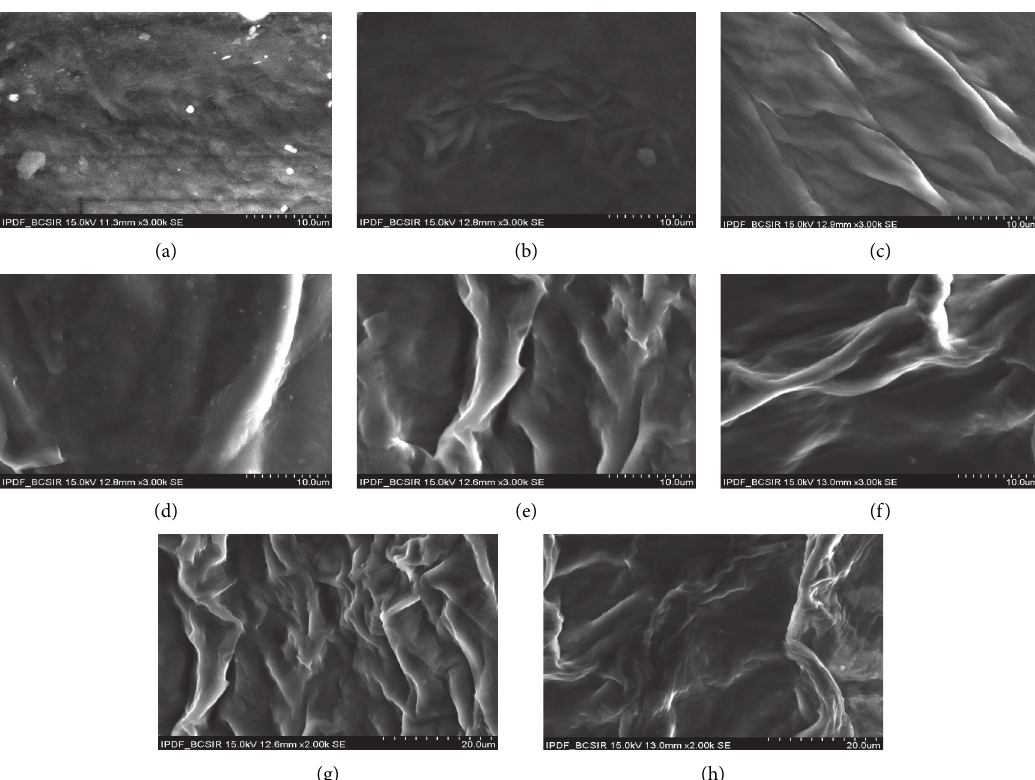
Figure 5: Microscopic surface appearance of the produced hydrogels. All of the hydrogels exposed well-developed cross-linked networks and porous topology. (a) X hydrogel surface morphology, (b) X :Ge :G surface morphology, (c) X : Ge: Peg: G surface morphology, (d) X: Ge :Ch: G surface morphology, (e) X :Ge :Peg :Ch: G surface morphology, (f) X :Ge :B: Ch:G surface morphology, (g) X :Ge :B :Peg :G surface morphology, and (h) X : Ge: B:Peg :Ch: G surface morphology. Abbreviations. Xanthan gum (X), boric acid (B), gelatin (Ge),